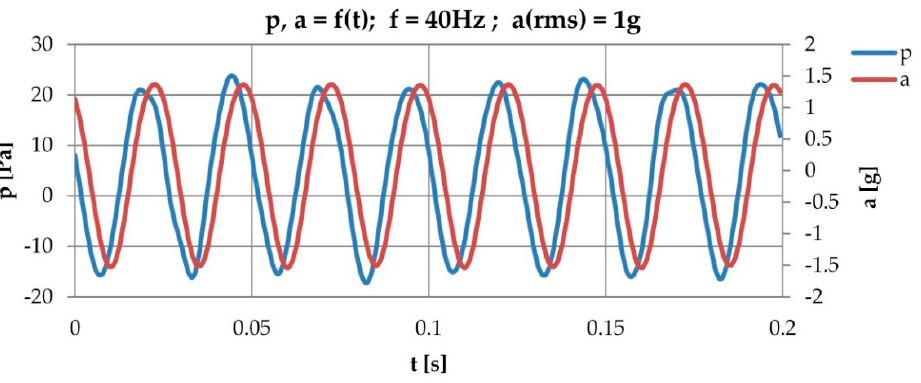
Figure 3. Dependency chart of the output signal from the sensor (RMS) depending on the accelera- tion, for a pressure difference equal to zero [25,26] .